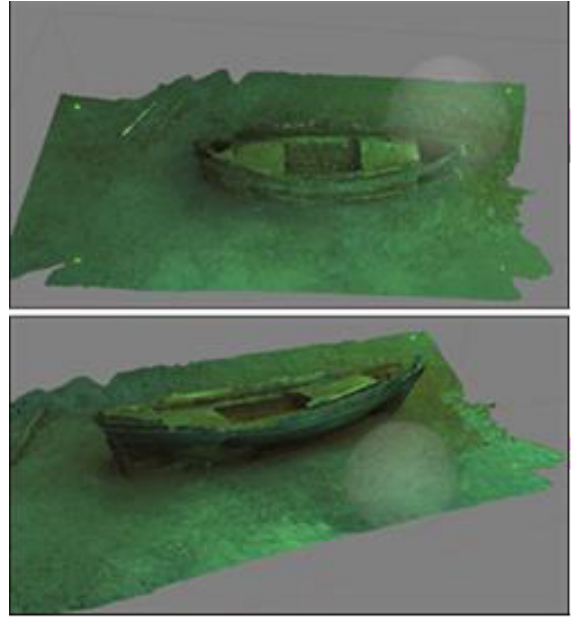
Figure 12. The produced